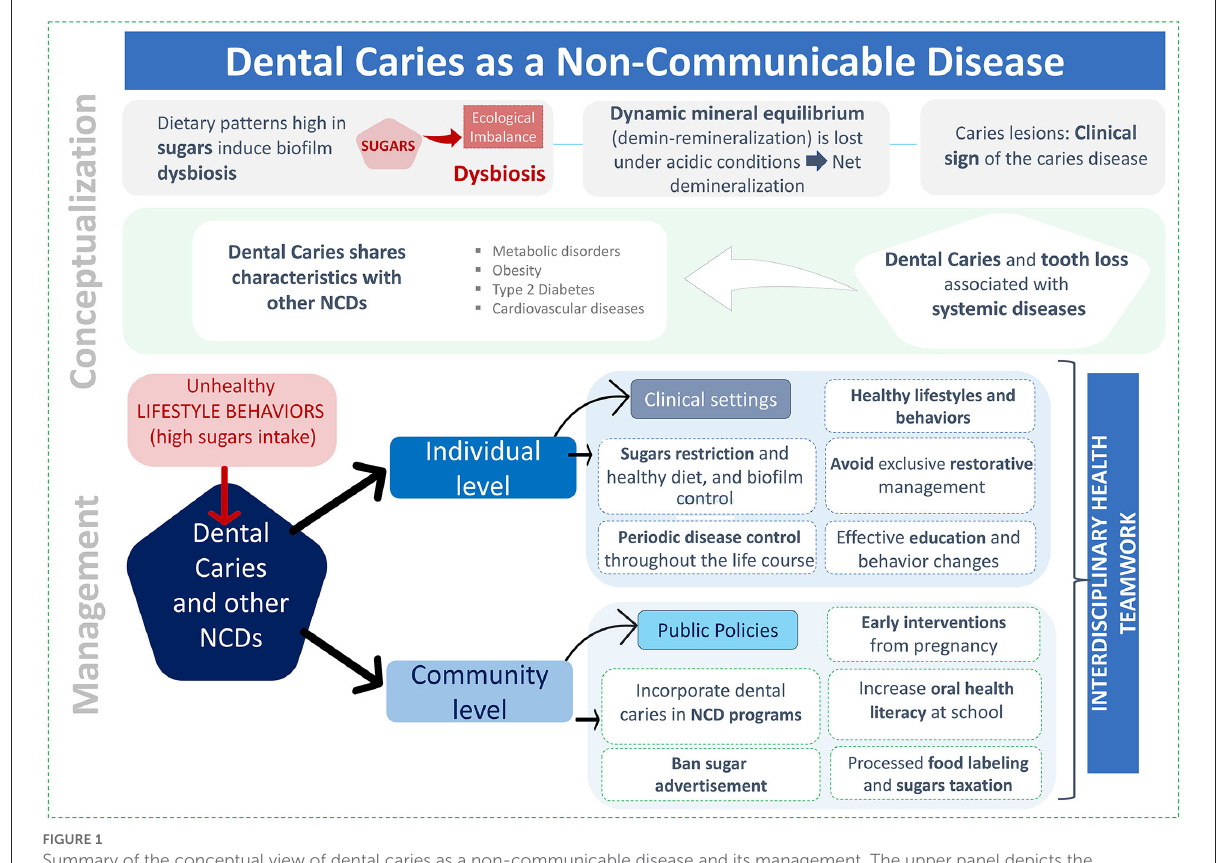
FIGURE1 Summary of the conceptual view of dental caries as a non-communicable disease and its management. The upper panel depicts the conceptualization of caries as a non-communicable disease. The bottom panel represents a schematic view of the proposed caries management, at the individual and community levels, both with an interdisciplinary